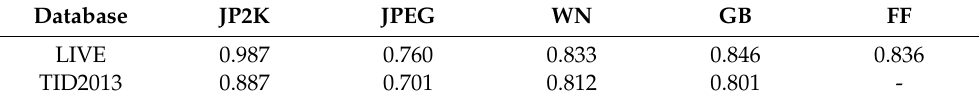
Table 7. Distortion type classification accuracy on LIVE and TID2013